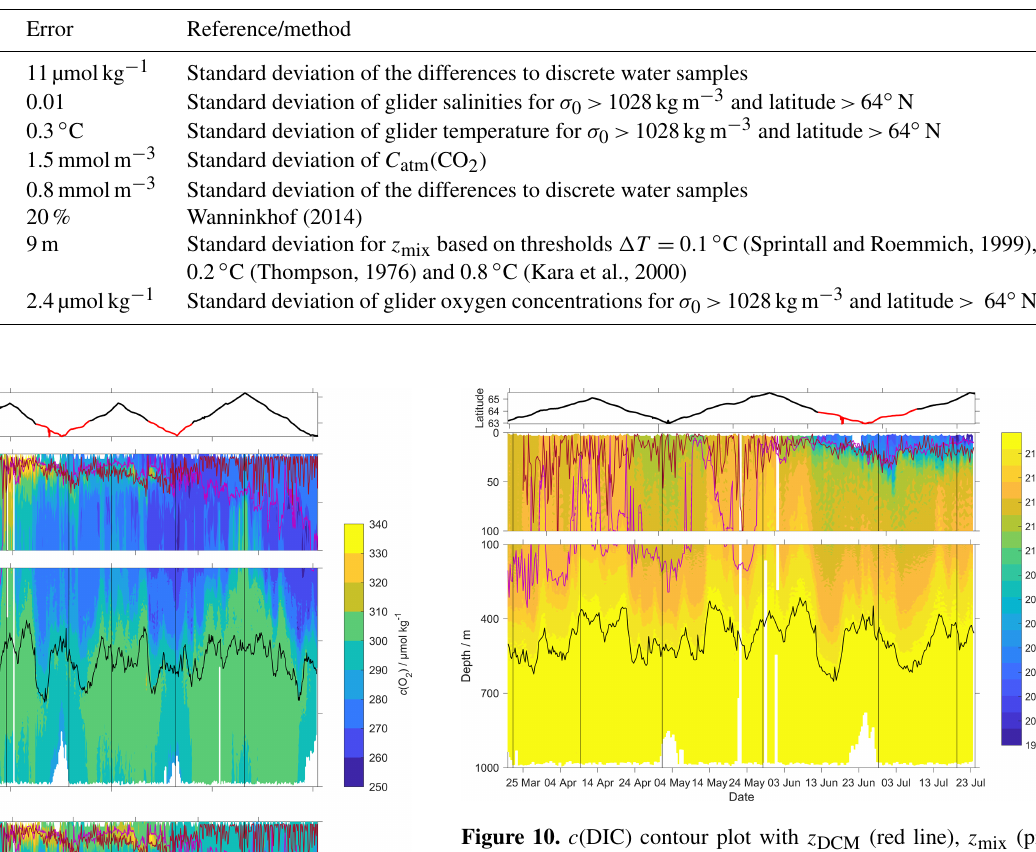
Table 2. Uncertainty associated with N (DIC) and N (O 2 ) input variables calculated by a Monte Carlo approach.